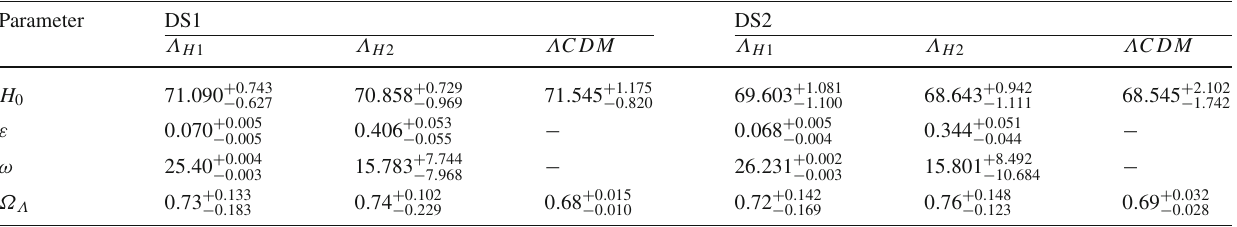
Fig. 4 One dimensional and two-dimensional marginalized confidence regions for the model parameters of Λ H 2 from DS2 data set Table 1 The fitting values for the considered models ( Λ H 1 , Λ H 2 and Λ CDM) obtained from two different joint analysis of data sets, namely DS1: SNe ( Pan ) + H ( z ) + BAO / CMB + H 0 and DS2: SNe ( Pan ) + H ( z ) + BAO / CMB